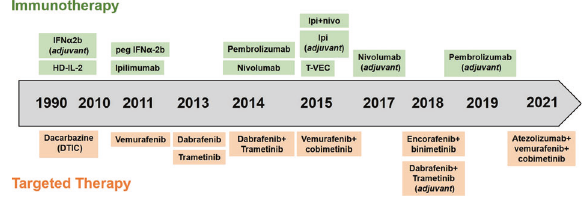
Fig. 2 Timeline for FDA-approved therapies for metastatic melanoma. HD high-dose, Ipi Ipilimumab, T-VEC talimogene